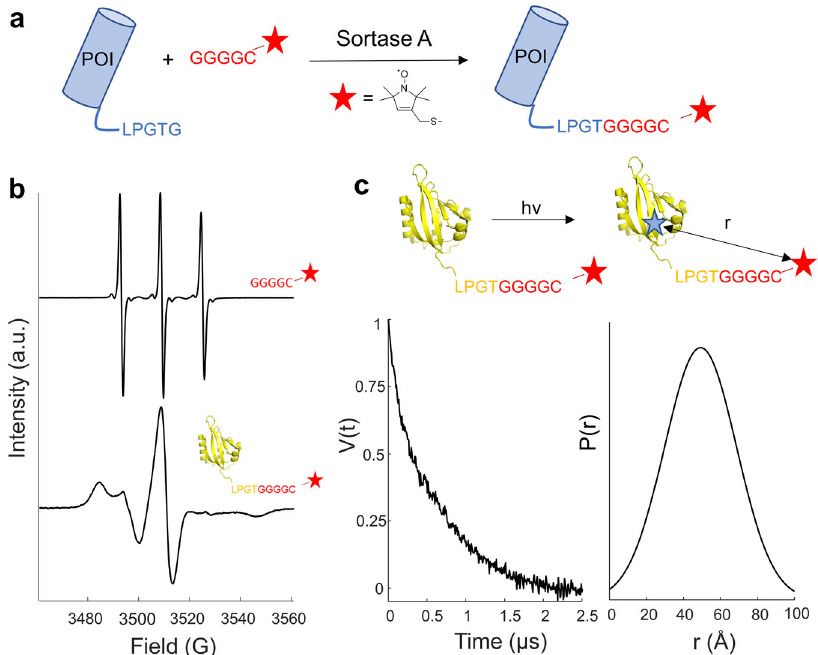
Fig. 3 Site-speci fi c C-terminal protein labeling using sortase A. a Sortase A catalyzes the ligation of a polyglycine probe (GGGGC) to an LPGTG recognition motif. For analysis using ESR spectroscopy, the cysteine of the glycine probe was conjugated to a nitroxide radical. b cw-ESR spectra of (top) labeled GGGGC peptide, (bottom) C terminally labeled A. thaliana iLOV. c Photoreduction of iLOV allows distance measurements between the fl avin NSQ and sortylated nitroxide radical. DEER measurements (time domain, left) for C-terminally labeled iLOV indicated a broad distance distribution